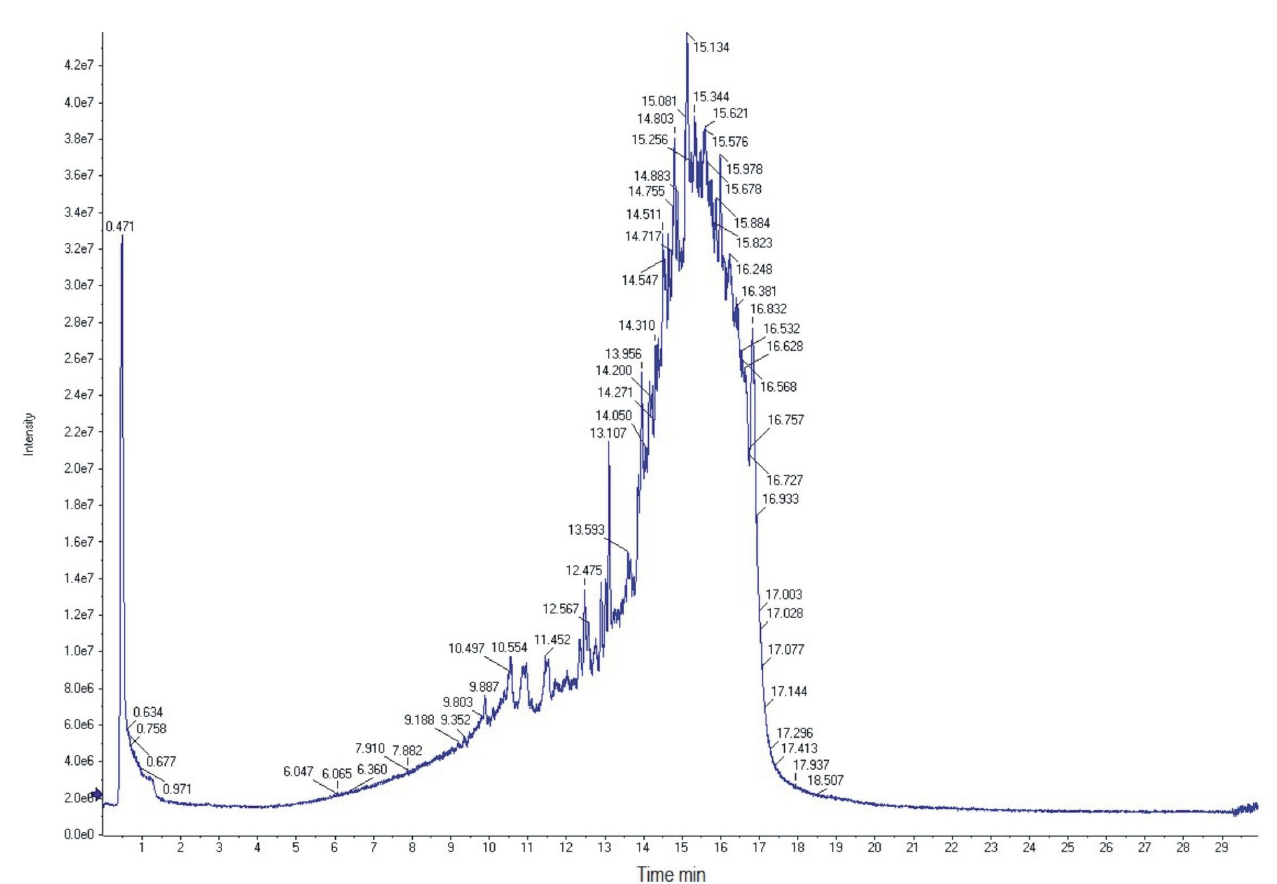
FIGURE 1 - Total ion chromatogram of E70 Psidium guajava L. extract obtained by negative-ion HPLC/MS/MS. Separation was achieved using injections of total extract, reversed-phase HPLC and gradient elution with water: